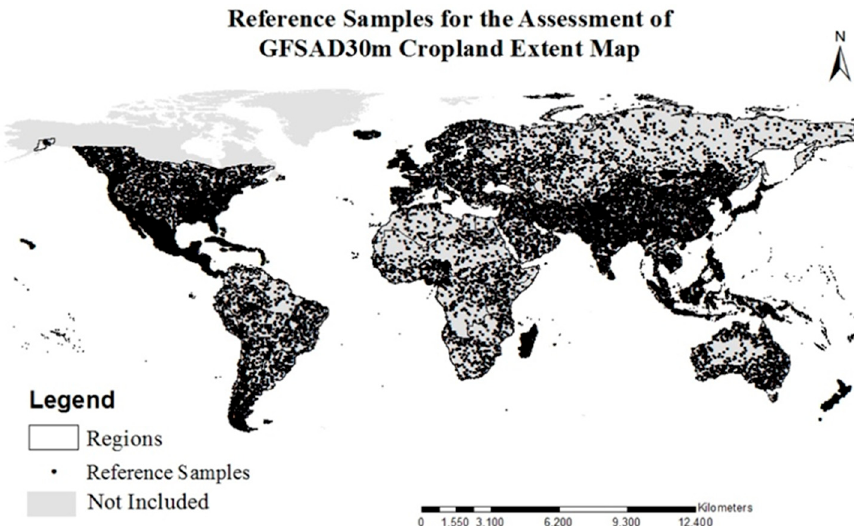
Figure 7. The distribution of regions and reference samples (Source: Independent reference datasets generated by assessment team from CDL and high-resolution imagery and field data collected for Australia [6,11]) used to assess the GFSAD30m cropland extent map.